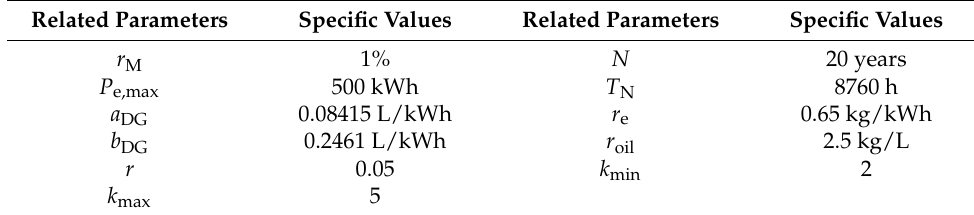
Table 3. Values of Important